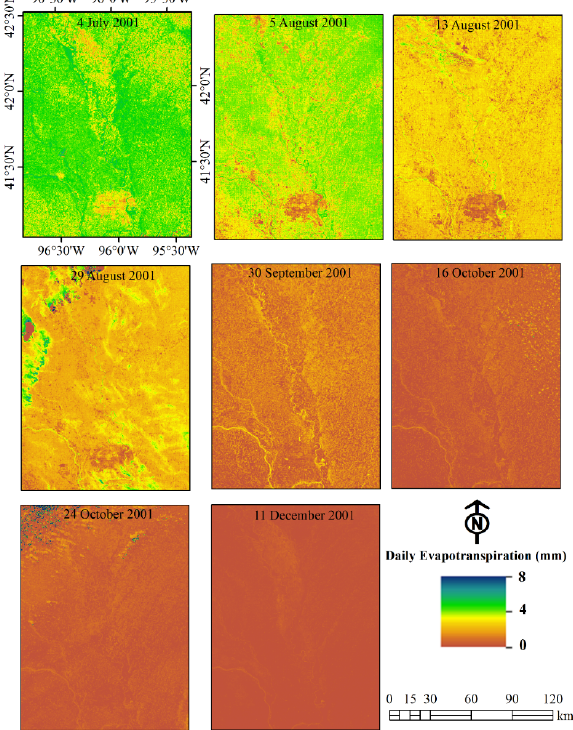
Figure 3. Daily evapotranspiration map for the days of satellite overpasses based on the Surface Energy Balance Algorithm for Land (SEBAL) model. Balance Algorithm for Land (SEBAL)